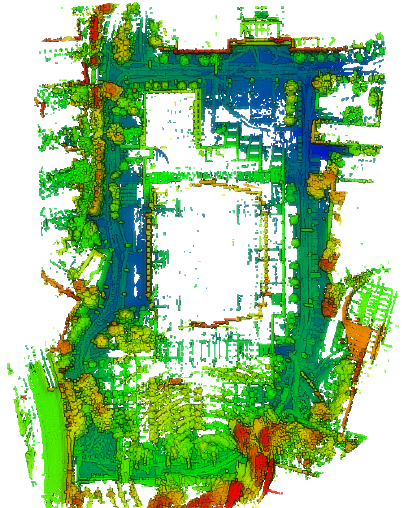
Figure 10. 3D point cloud map of the road around the Zall Stadium